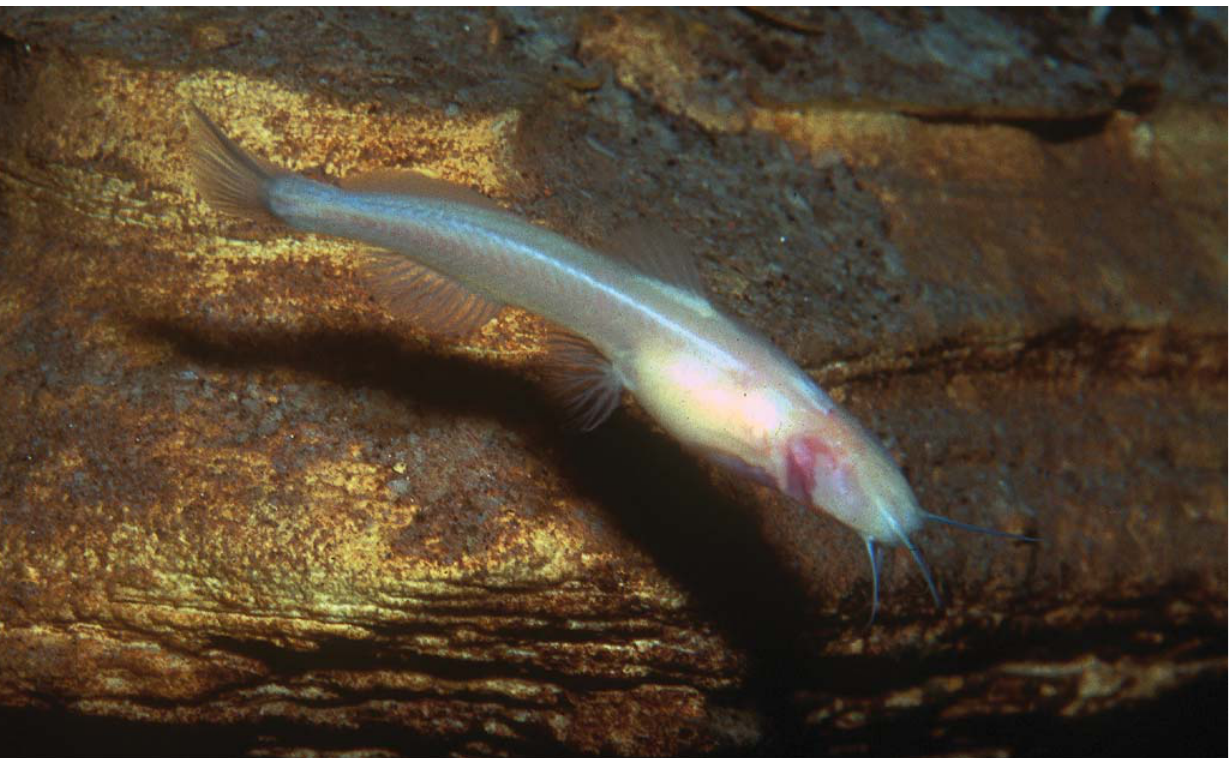
Fig. 12. Rhamdiopsis krugi , ca . 30.0 mm SL, adult, live specimen photographed in the nature in August, 1991, not collected; Poço Encantado cave, ca . 7 km from left margin of the rio Una, Municipality of Itaetê, State of Bahia, Brazil.